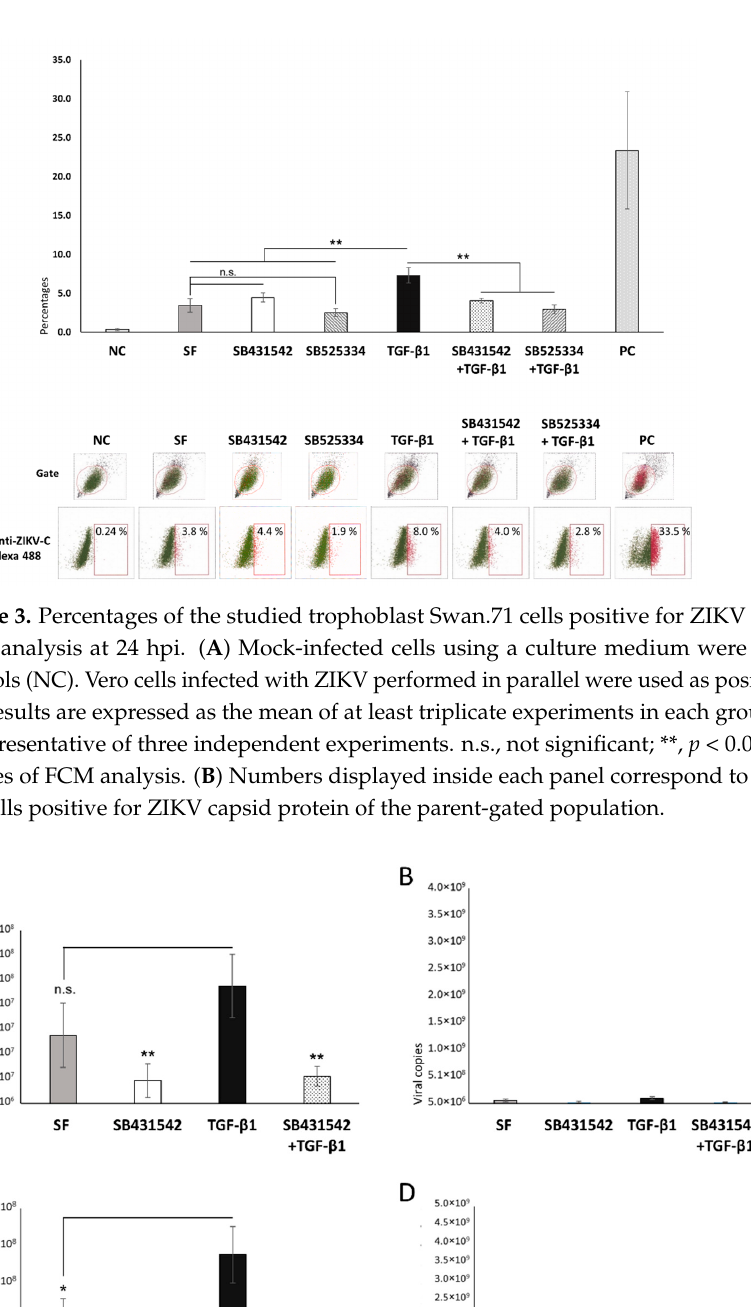
Figure 4. Quantifying viral progeny production in the supernatants collected at 48 hpi by real ‐ time PCR. ( A , B ). Pre ‐ infection treatments of TGF ‐β 1 and/or its inhibitor SB431542. Swan.71 cells were cultured and pre ‐ treated with TGF ‐β 1 and the inhibitor before ZIKV infection. ( C , D ). Post ‐ infection treatments of TGF ‐β 1 and/or its inhibitor SB431542. The Swan.71 cells were infected with ZIKV